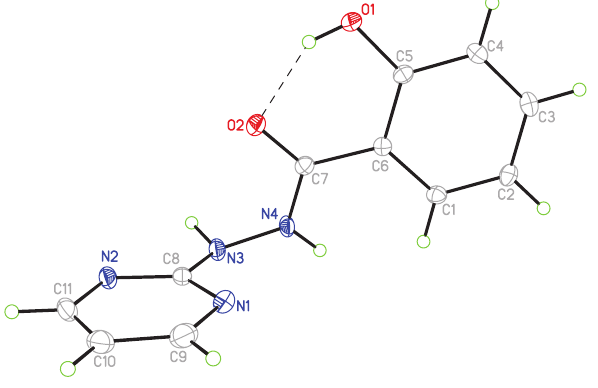
Table 1: Data collection and handling.